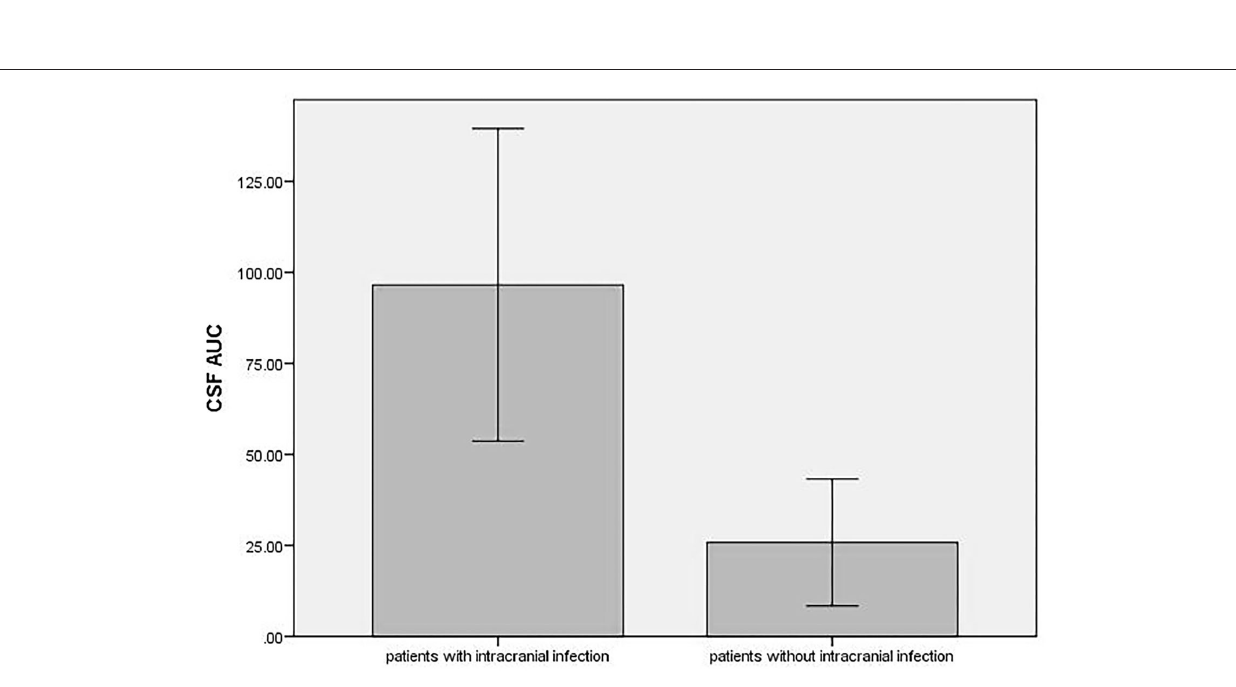
FIGURE 4 | The CSF AUC in patients with and without intracranial